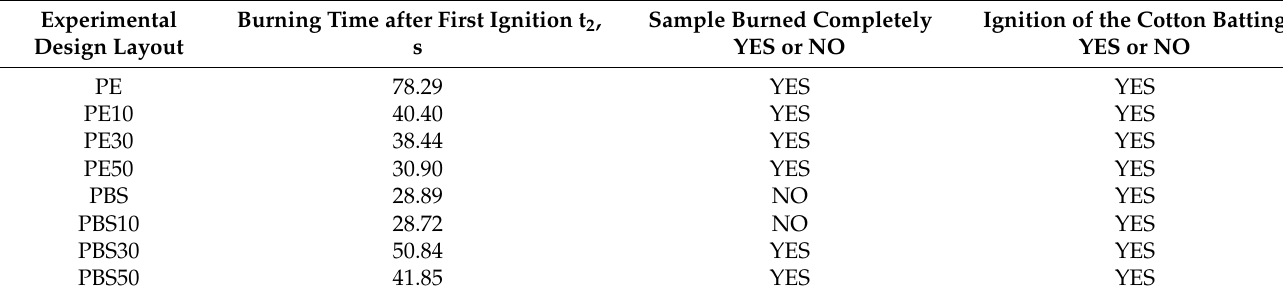
Table 3. Results of vertical flammability